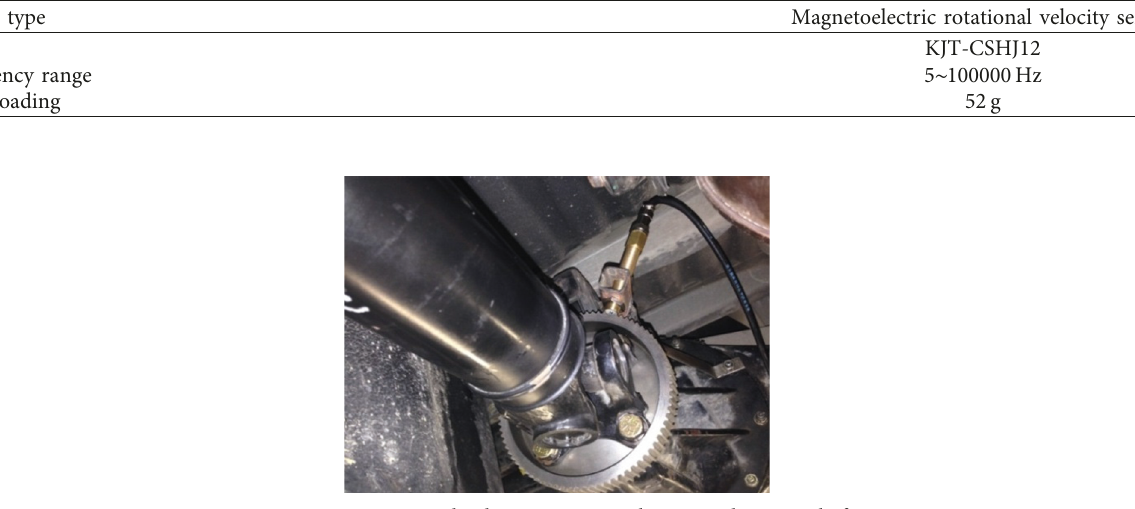
Figure 18: Rotational velocity sensor at the rear axle input shaft.